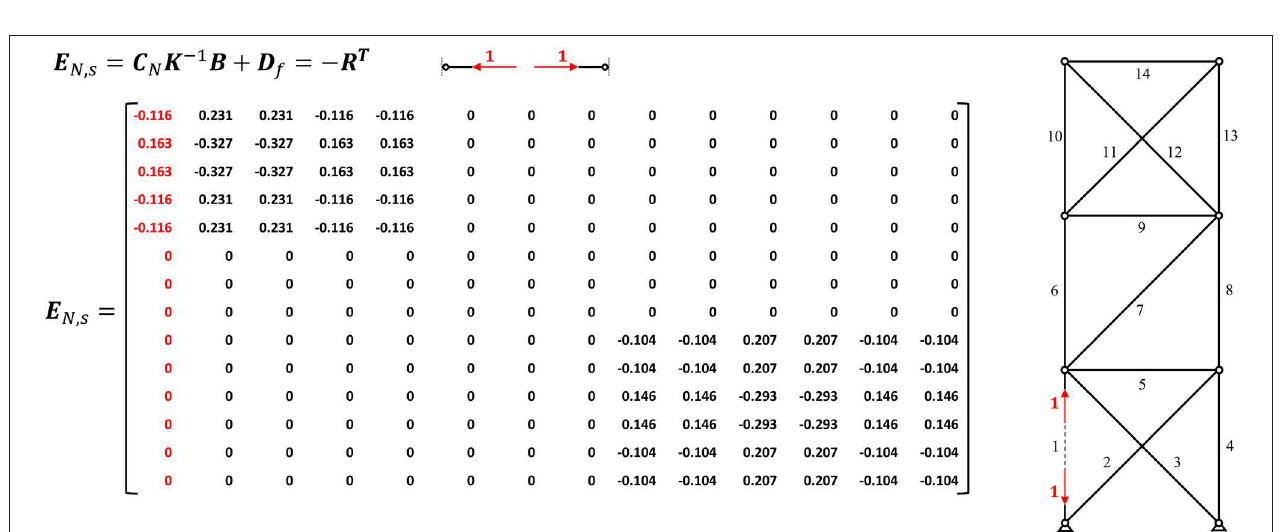
FIGURE 2 | Influence matrix of axial forces due to serial linear actuation E N , s of an exemplary truss.